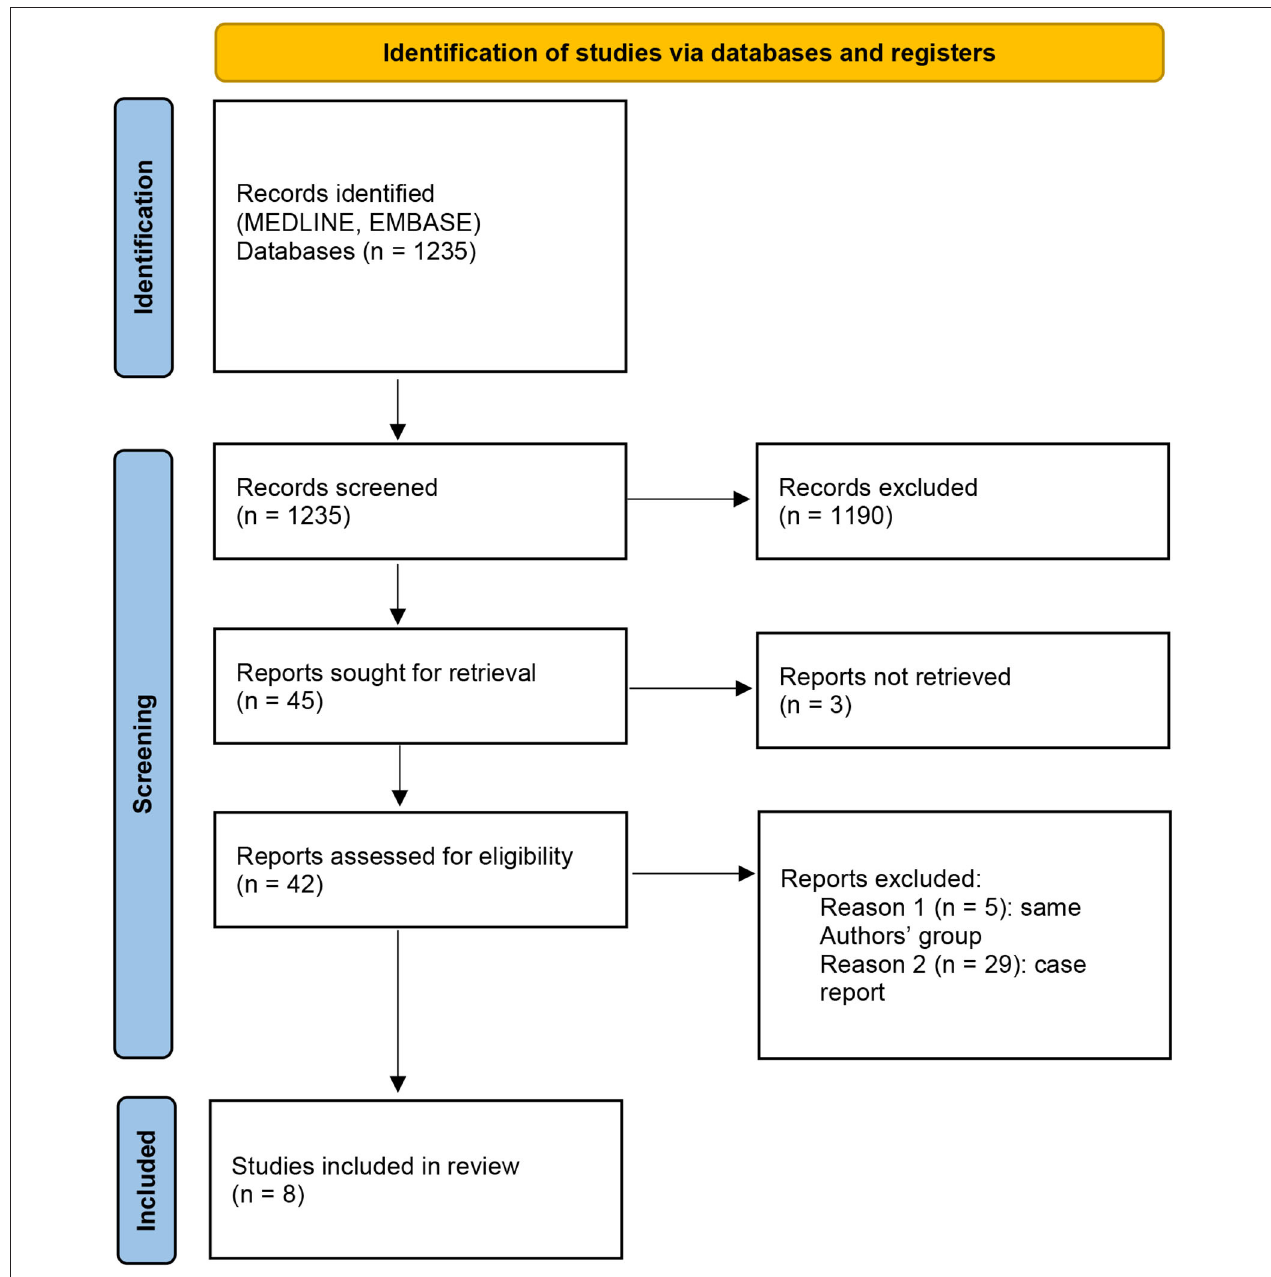
FIGURE 2 | Preferred Reporting Items for Systematic Reviews and Meta-Analyses (PRISMA) 2020 flow